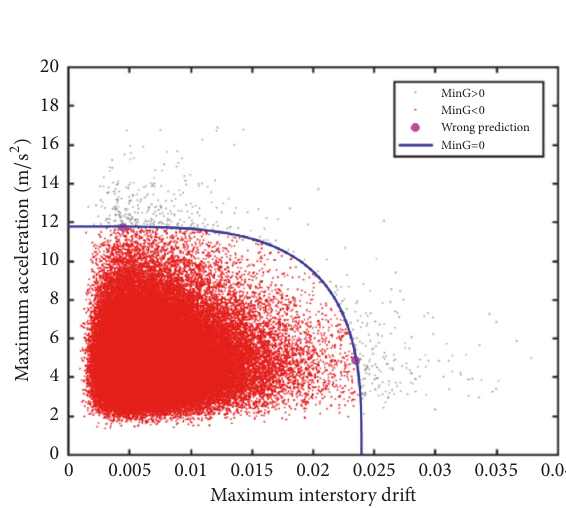
Figure 7: Sign of the minimum performance function with N 1 =3 and N 2 =4 predicted by